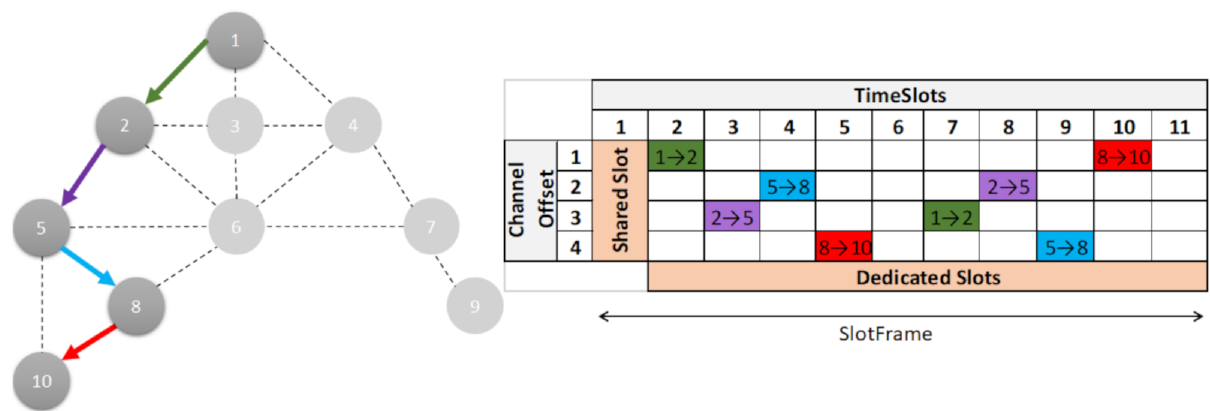
Figure 6. Topology of 10 nodes. Time Slotted Channel Hopping (TSCH) Scheduler of a 5-node Path with NR = 2.